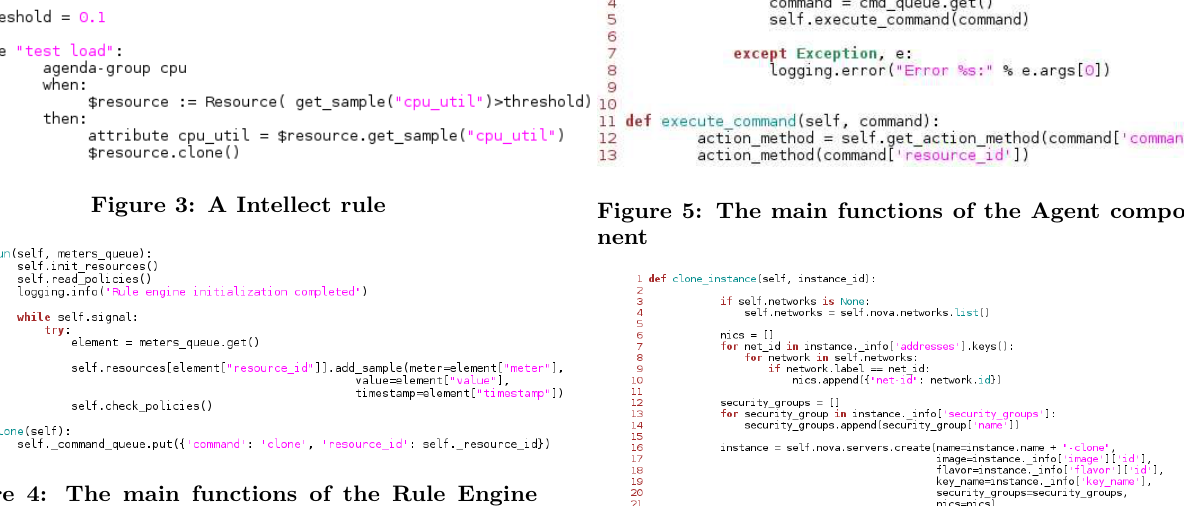
Figure 4: The main functions of the Rule Engine component